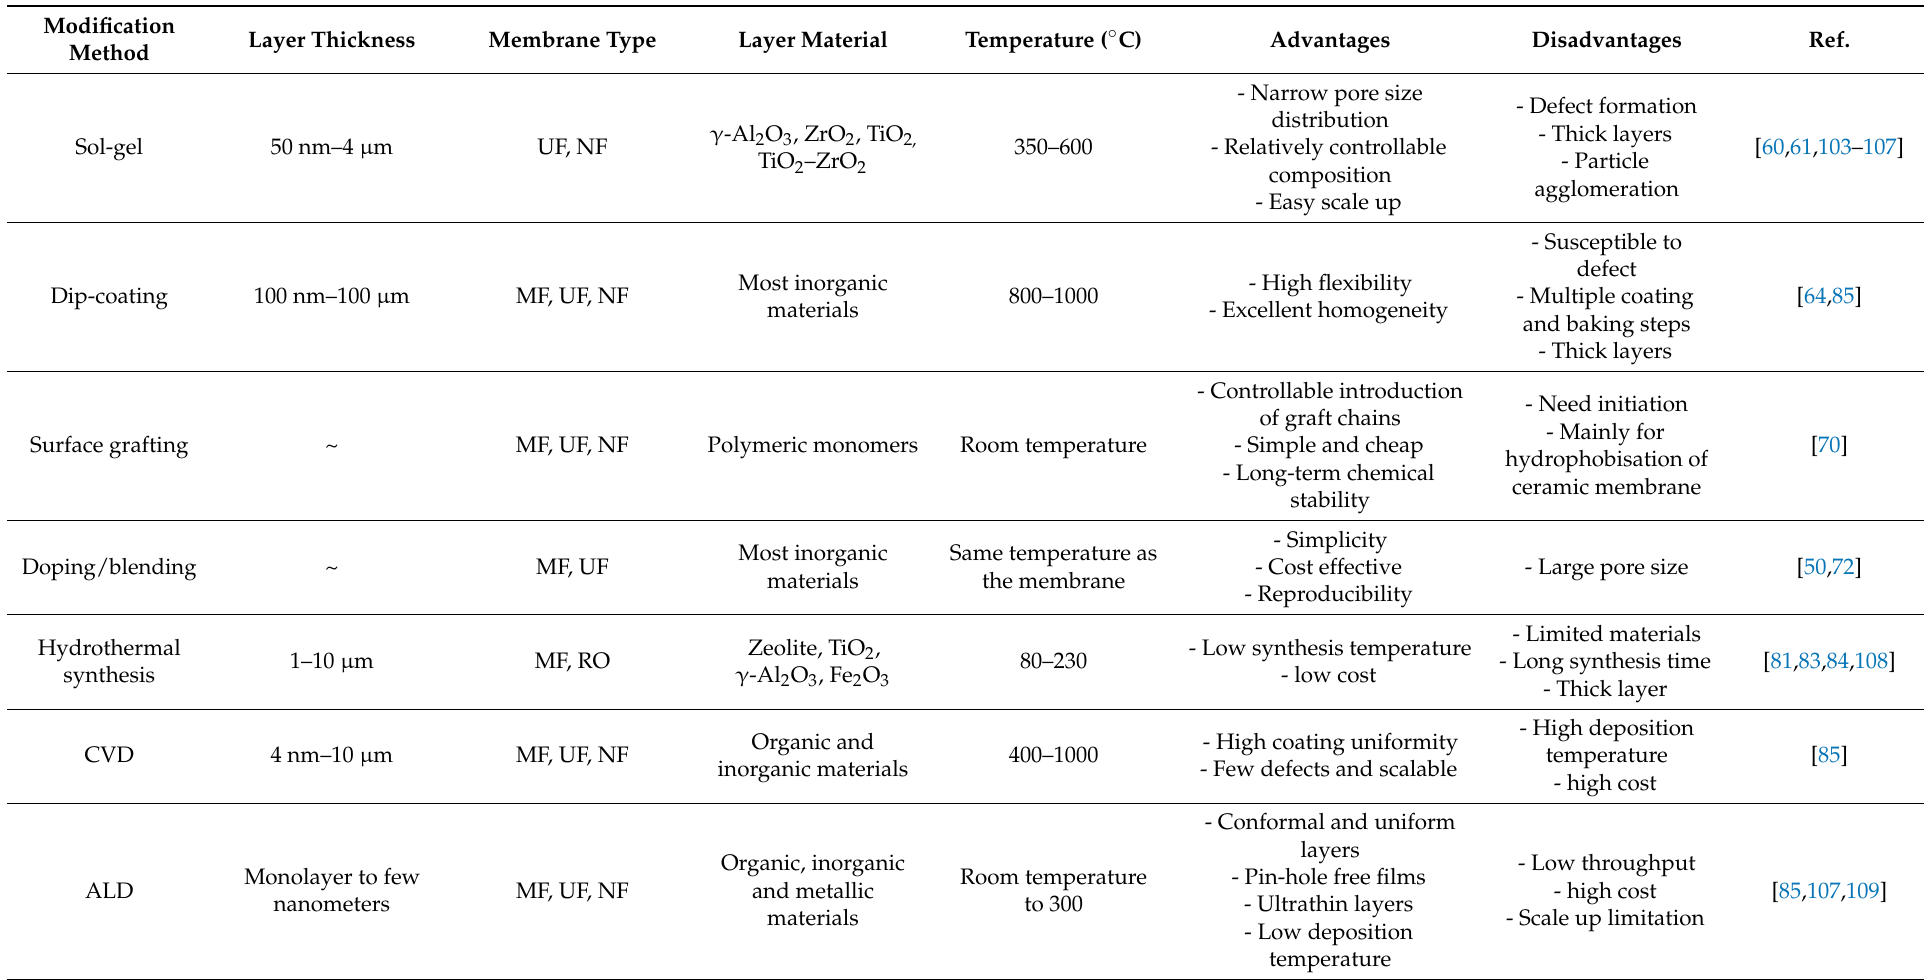
Table 1. Comparison of various ceramic membrane modification methods for oily wastewater